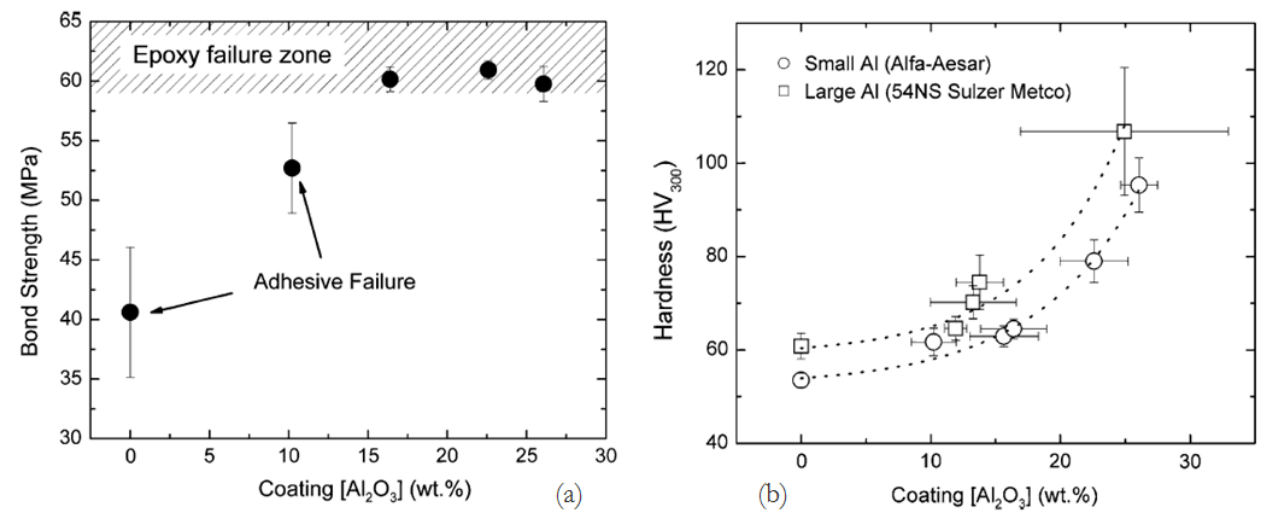
Figure 11: a) Bond strength against coating Al 2 O 3 concentration; b) Vickers hardness measurements against Al 2 O 3 concentration